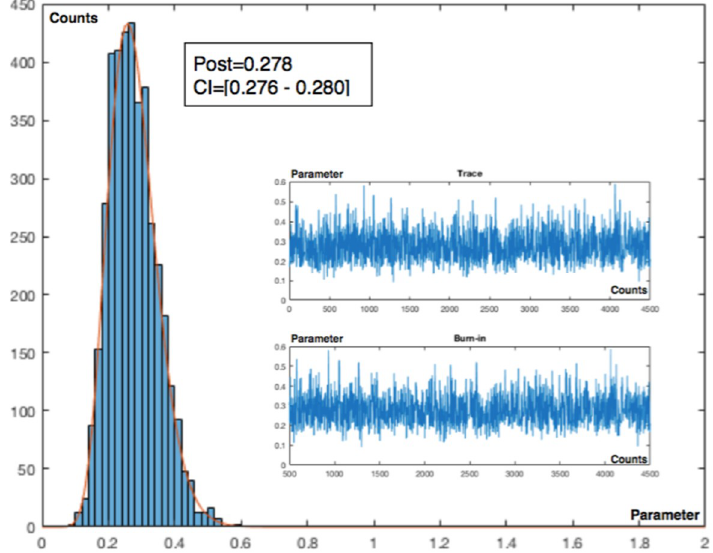
Figure 18. Metropolis–Hastings. Interval 8. Sampling n = 4500, burn = 500; 10 cycles. Acceptance rate (AR) = 58%.